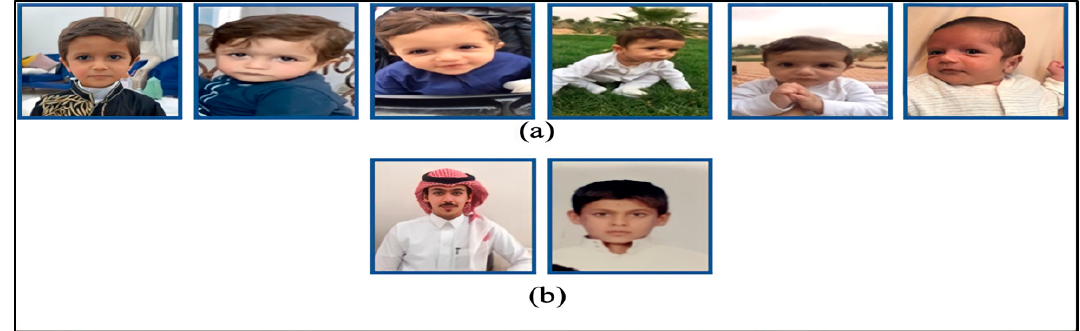
Figure 18. Samples of various age stages of the person: ( a ) represents early stages ( b ) later stages.